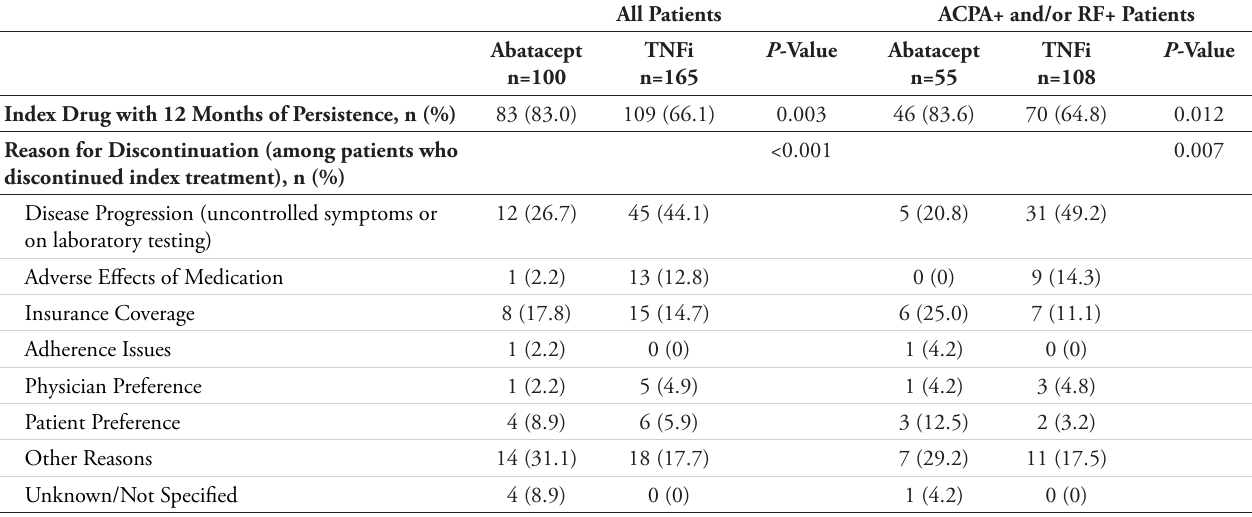
Table 2. Treatment Persistence and Reason for Discontinuation